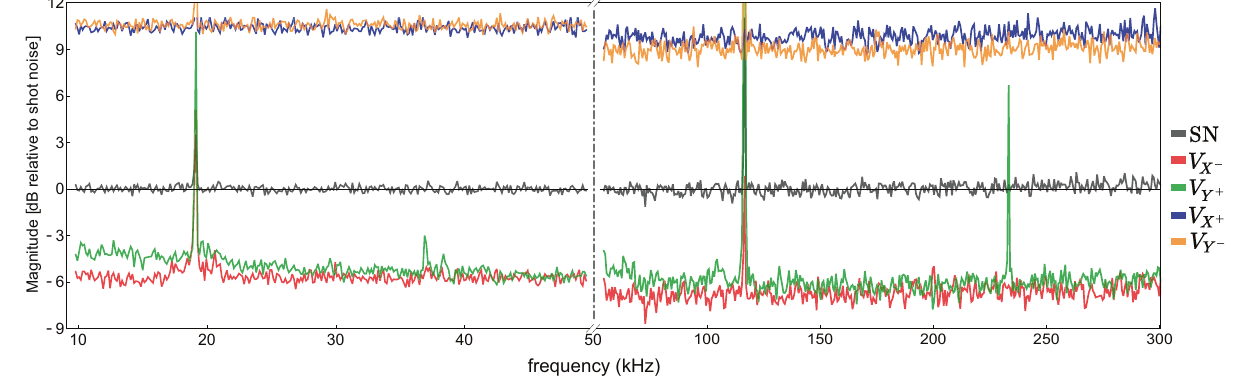
Fig. 2 | Spectra of the EPR quadratures normalized to shot-noise level (SN) for the frequency range 10 to 300 kHz. The left plate shows the quantum noise suppression optimized for low spectral frequencies (10 – 50kHz), while the right part corresponds to the best correlation level achieved in 50 – 300kHz spectral Note1and5).Theobservables X ± ( Y ± )arerecordedbyinitiallysettingof